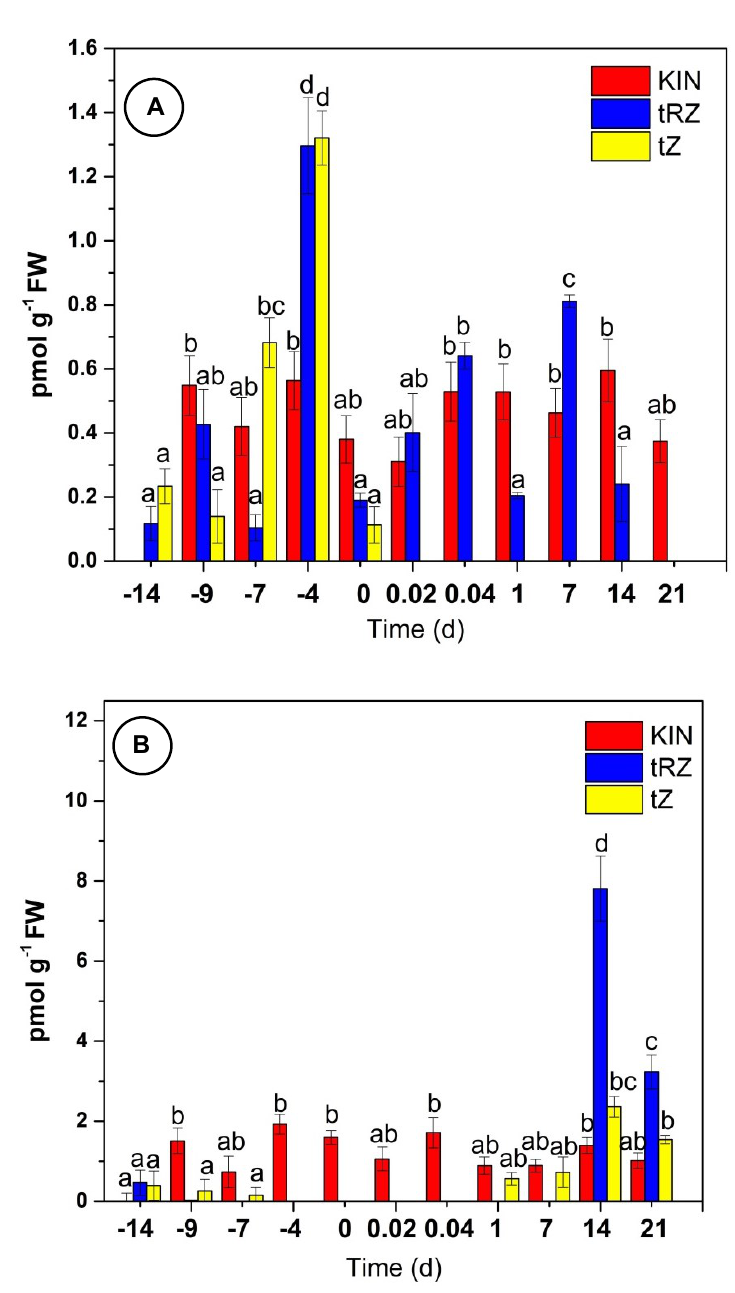
Figure 4. Endogenous CK content during SE in C. canephora : ( A ) without L-Kyn; ( B ) with L-Kyn. A total of 100 mg of tissue was collected from the beginning of the preconditioning of the plantlets (days -14, -9, and -4) to the induction day (day zero). Samples were collected after the induction (0.02, 0.04, 1, 7, 14, and 21 d) of SE. For the L-Kyn experiment, the inhibitor (1 µ M) was added at the beginning of the pre-treatment. The chromatographic system is described in Materials and Methods. All analyses were performed with three biological replicates from two independent experiments. FW, fresh weight; bars display standard error ( n = 3); KIN (red); tZ (yellow); and tZR (blue). Different letters represent the statistical significance of mean differences between each determination at a given time according to the Tukey test ( p < 0.05).